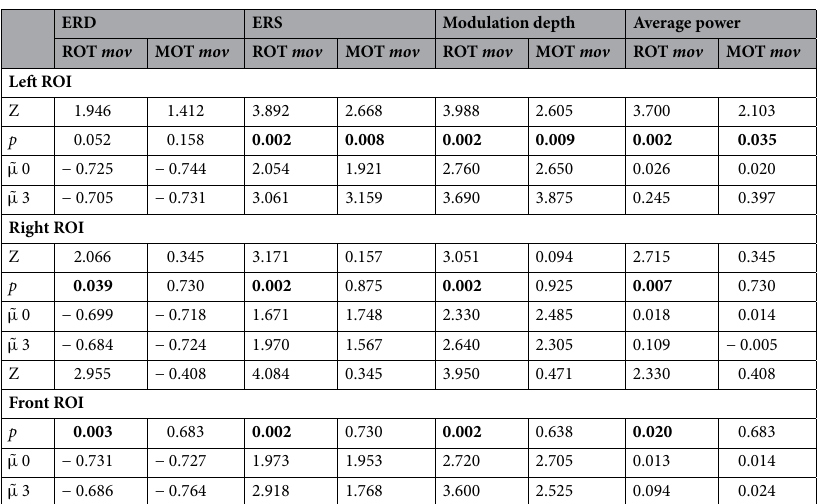
Table 2. Comparison of beta ERD, ERS, modulation depth and mean power magnitude during the baseline ( mov 0) and third block ( mov 3) in ROT mov and MOT mov. Significant differences are reported in bold (p < 0.05). Results of related-samples Wilcoxon Signed Rank Test on the differences between the two blocks ( mov 3 vs. mov 0) in each ROI and group (ROT mov and MOT mov ). Z, test statistic; p, p values; ˜ µ , median.